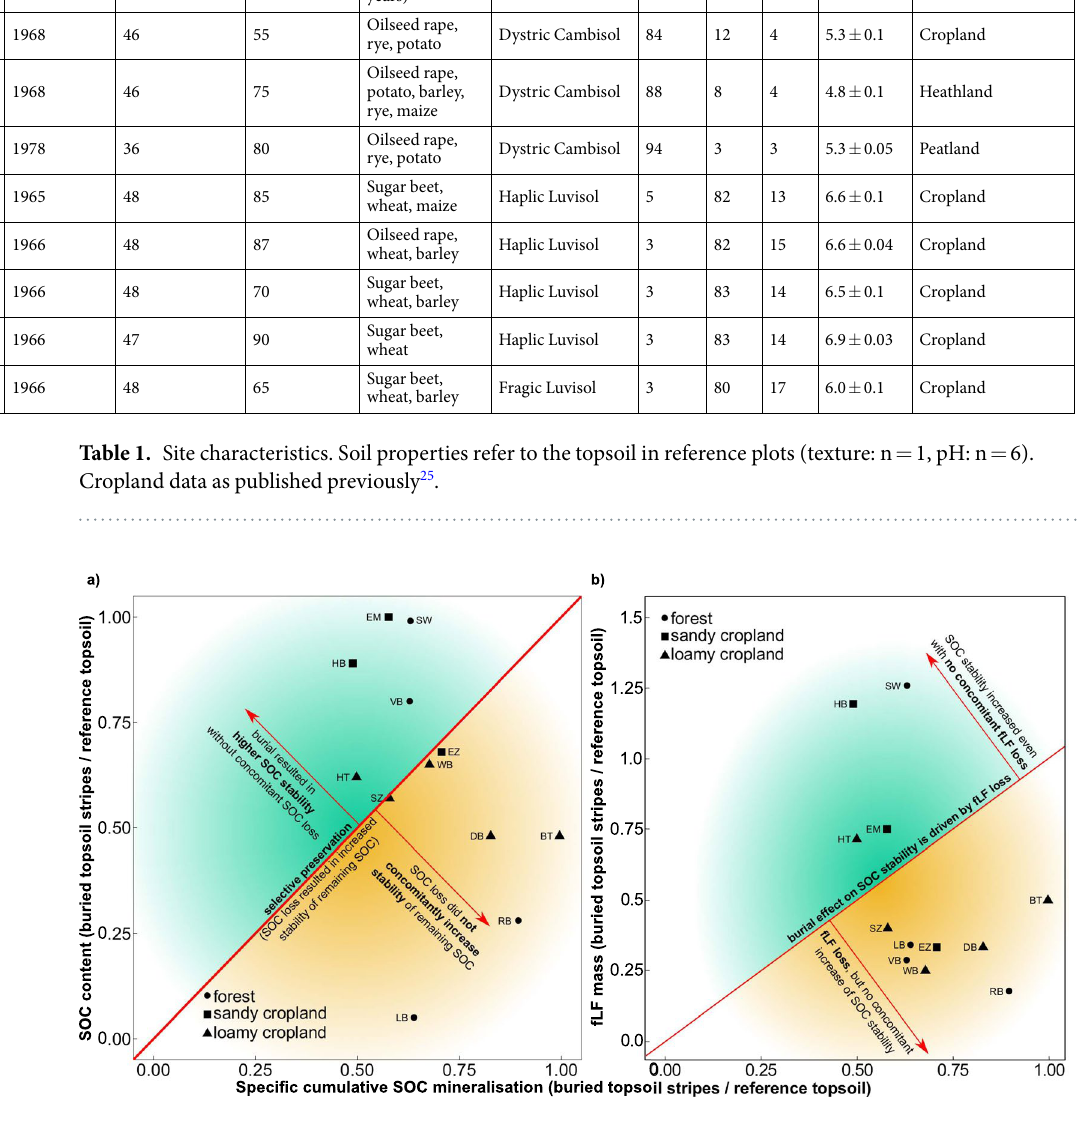
Figure 7. Correlation between ratio of specific cumulative SOC mineralisation in buried topsoil stripes to that in reference topsoil. ( a ) ratio of SOC content in buried topsoil stripes to that in reference topsoil as well as ( b ) ratio of fLF mass in buried topsoil stripes to that in reference topsoil. Sites abbreviations: LB - Lindenburg, RB -Rebberlah, SW - Schwenow, VB - Viborg, EZ - Elze, EM - Essem¨uhle, BT - Banteln, DB - Dr¨uber, HT - Halchter, SZ - Salzgitter and WB –